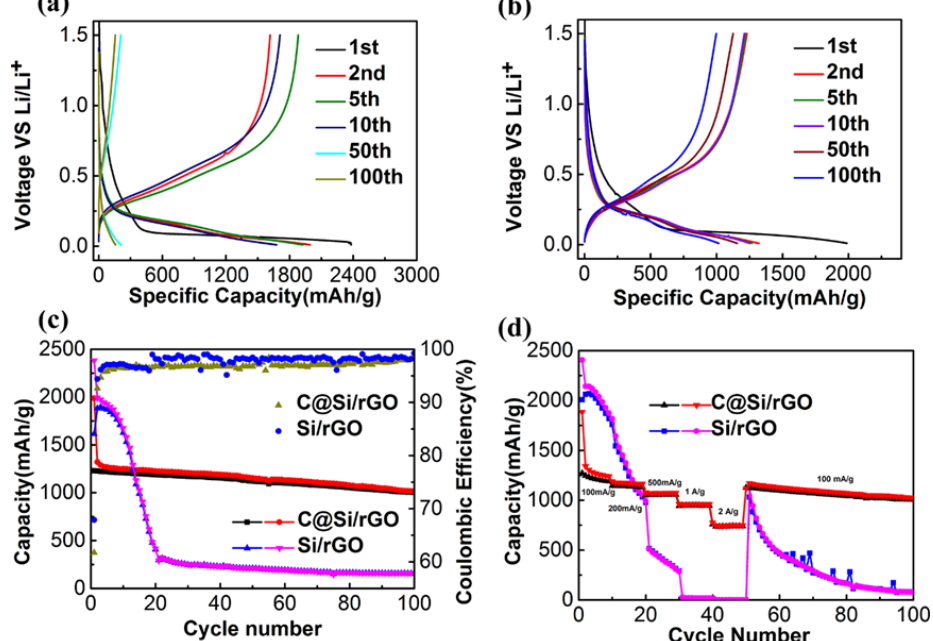
Figure 6. ( a , b ) Galvanostatic discharge / charge curves of Si / rGO and C@Si / rGO film electrodes; ( c ) long-term cycling performances of Si / rGO and C@Si / rGO film electrodes at current density of 100 mAg − 1 ; ( d ) rate capabilites of Si / rGO and C@Si / rGO film electrodes under di ff erent current